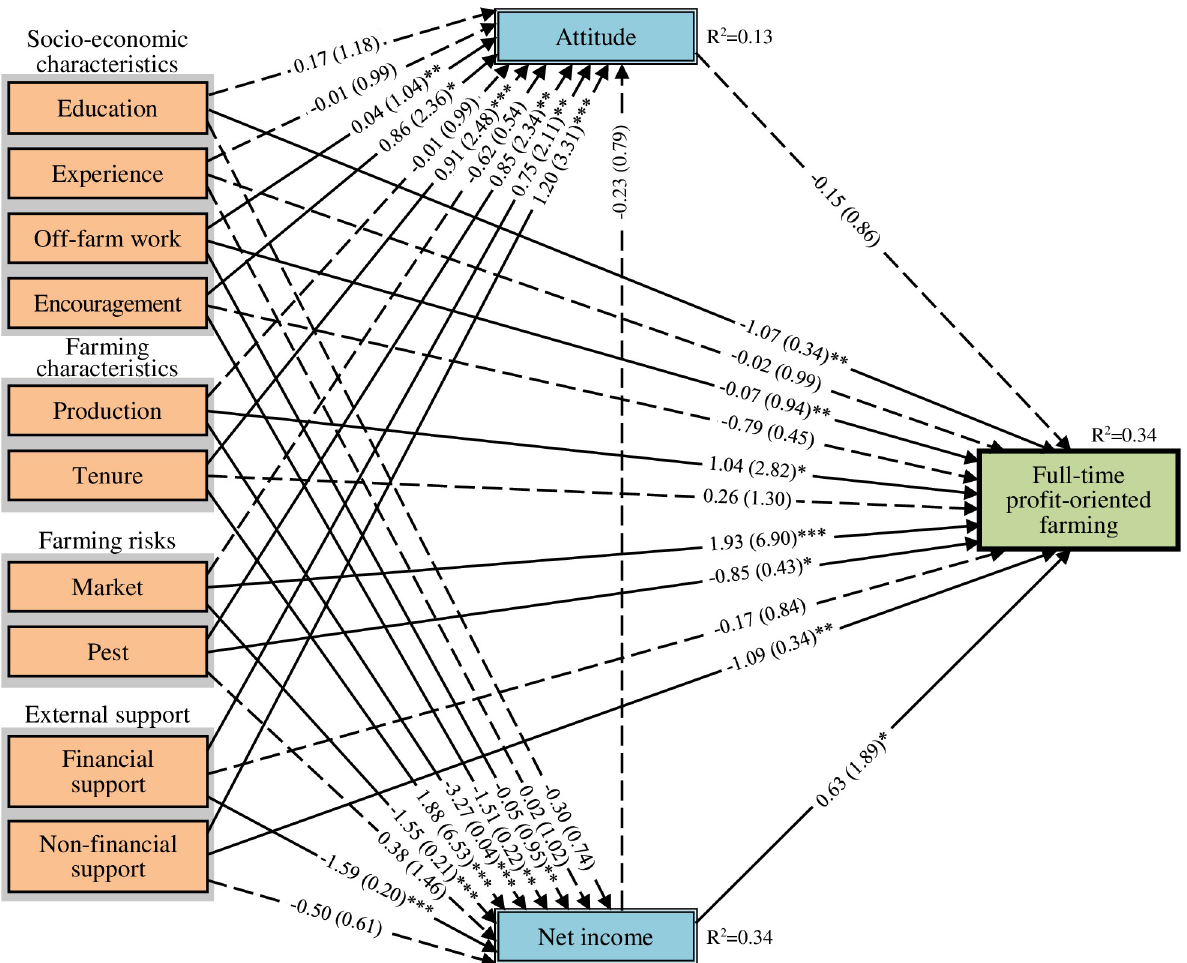
Fig 6. Path diagram of result of generalised structural equation modelling for full-time profit-oriented farming. Notes: 1) number of full-time profit-oriented farmers = 93, 2) number of samples (n) = 176, 3) � , �� , ��� significant at 10%, 5%, and 1% levels, 4) Dashed lines represent statistically insignificant path coefficients, 5) Numbers in the brackets were odds ratios, and 6) Second-order bias-corrected Akaike information criterion (AICc) = 876.71.